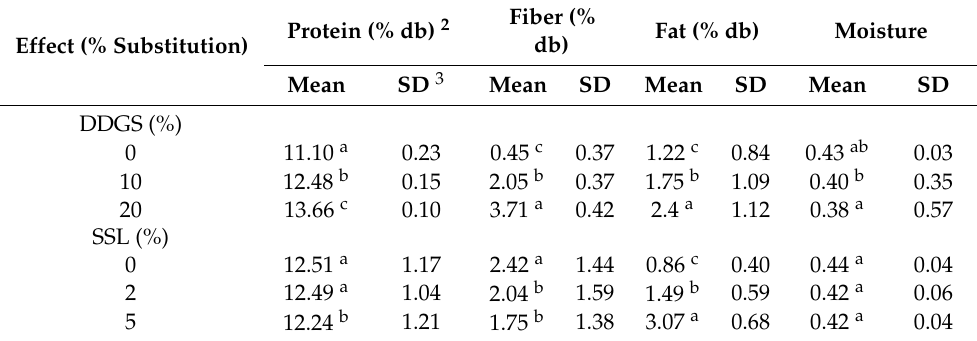
Table 2. Main effects on chemical properties of baked breads 1 .